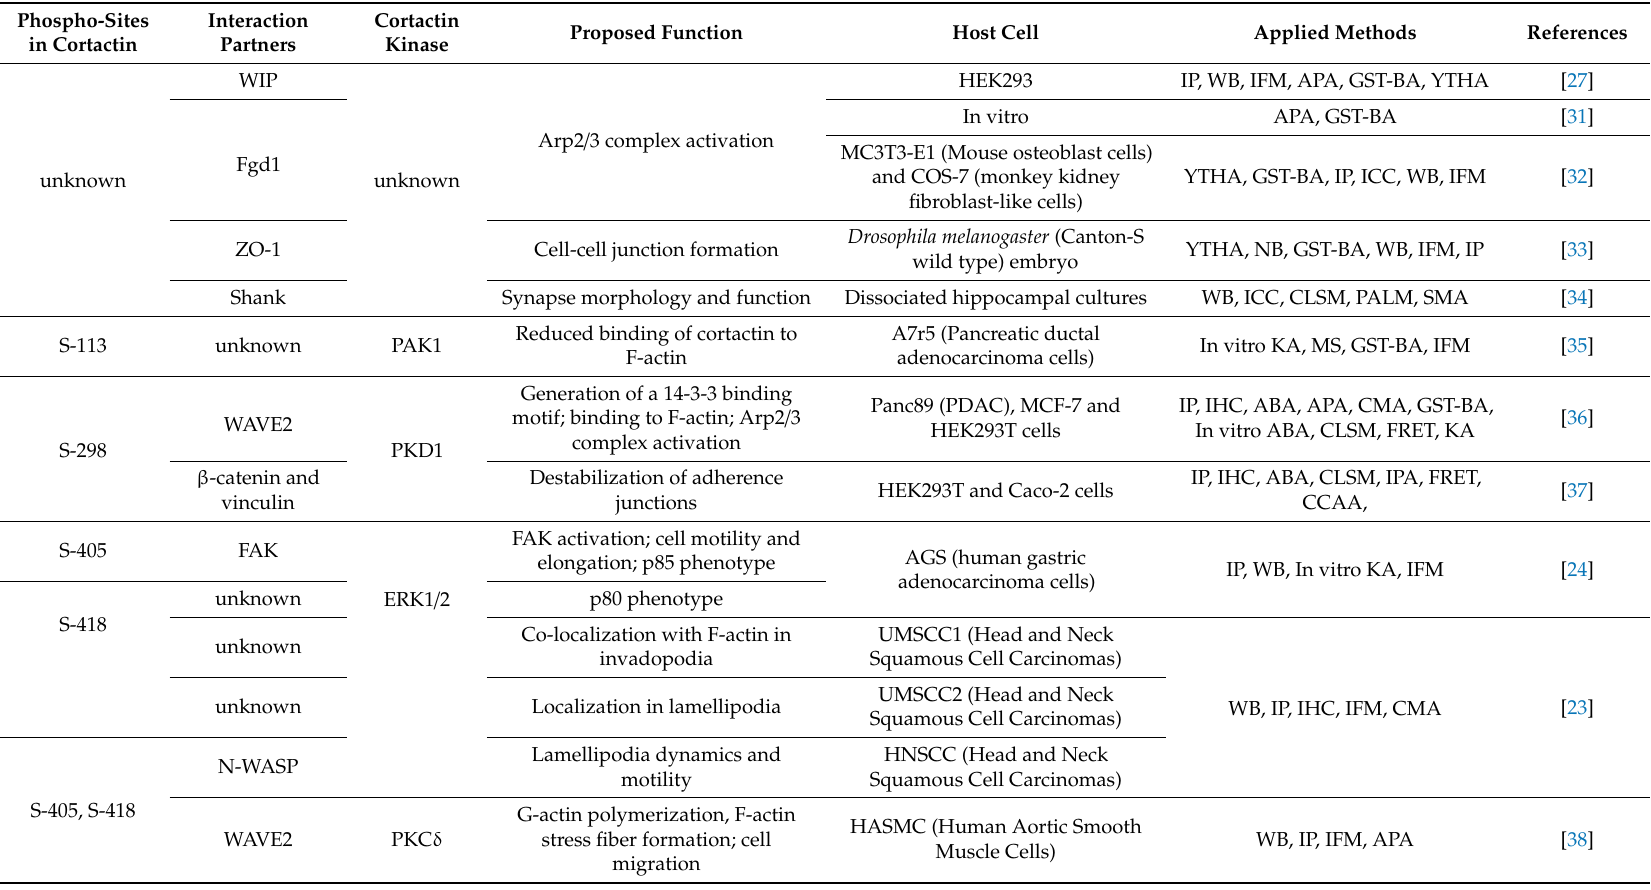
Table 1. Reported interacting partners of cortactin and proposed functions in health and